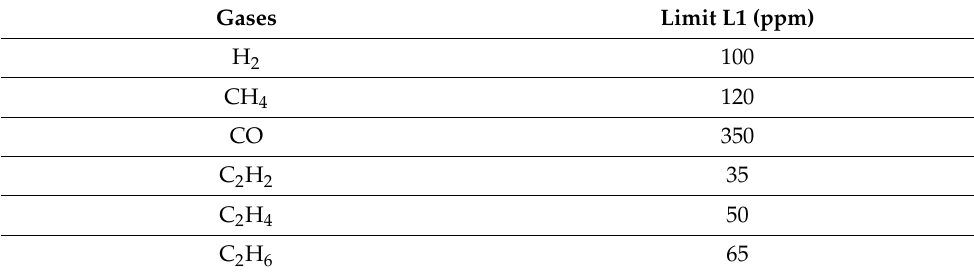
Table 6. Limit L 1 specified for each gas and its values that cannot be exceeded.